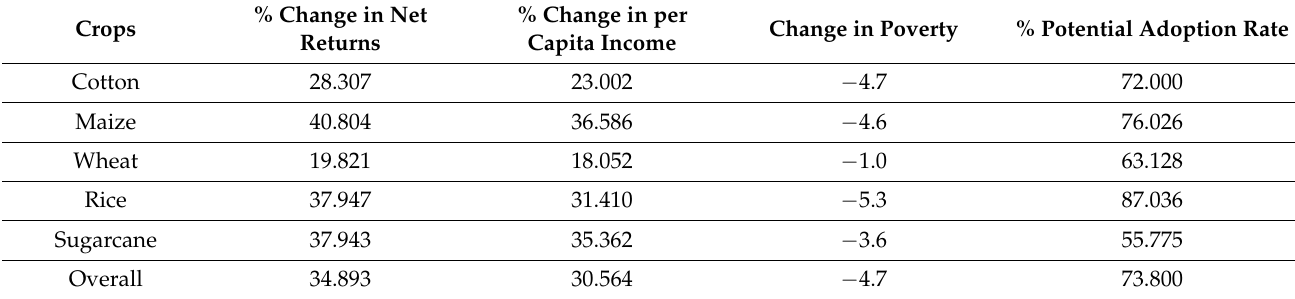
Table 4. Socioeconomic impacts of benefits offered by a high-efficiency irrigation system.